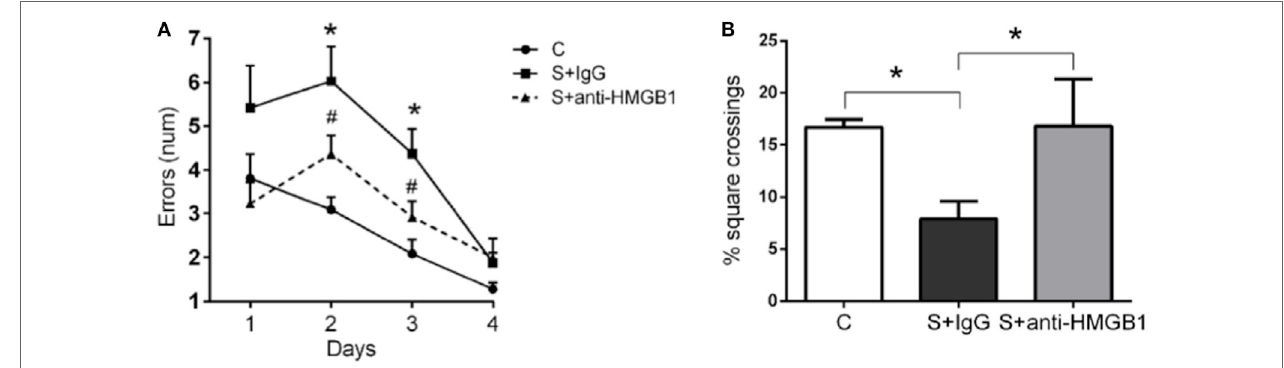
FigUre 1 | anti-hMgB1 improves memory dysfunction and anxiety in aged rats . Spatial memory was evaluated in the Barnes maze. Rats that had undergone liver surgery had significant memory impairments as detected by error numbers in reaching the correct target box (a) . Treatment with anti-HMGB1 mAb significantly improved postoperative memory dysfunction on both days 2 and 3 after surgery. (B) Anxiety was measured in an open field on postoperative day 3. Treatment with anti-HMGB1 mAb prevented postoperative anxiety as compared to the S + IgG group. Results are expressed as mean ± SEM ( n = 12). * p < 0.05 vs. C; # p < 0.05 vs. S + IgG group by two-way repeated measures ANOVA for Barnes Maze and one-way ANOVA for open field. Abbreviations: C, control; S,